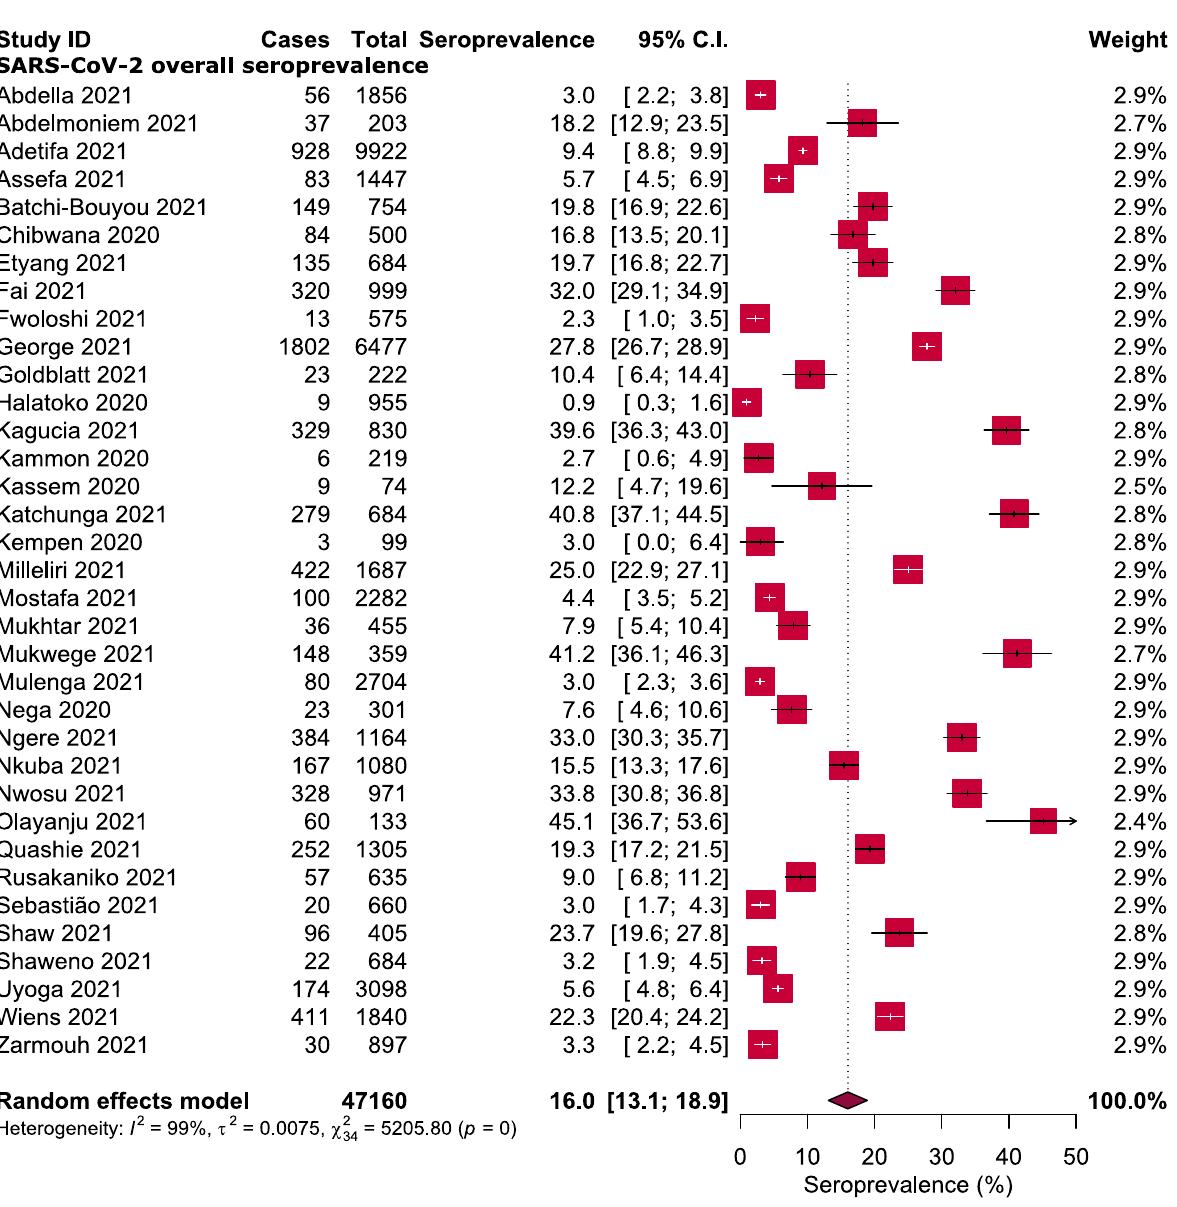
Figure 2. Overall seroprevalence of SARS-CoV-2 antibodies in Africa